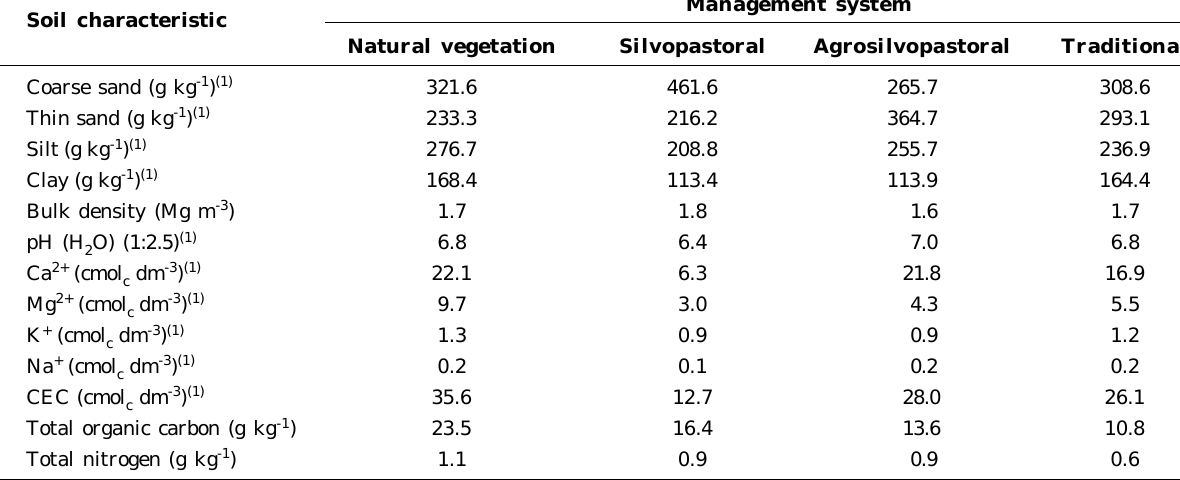
Table 1. Chemical and physical characterization in the 0-40 cm layer of typical Ortic Chromic Luvisol under natural vegetation and silvopastoral, agrosilvopastoral and traditional agricultural systems in Sobral, Ceará, Soil characteristic